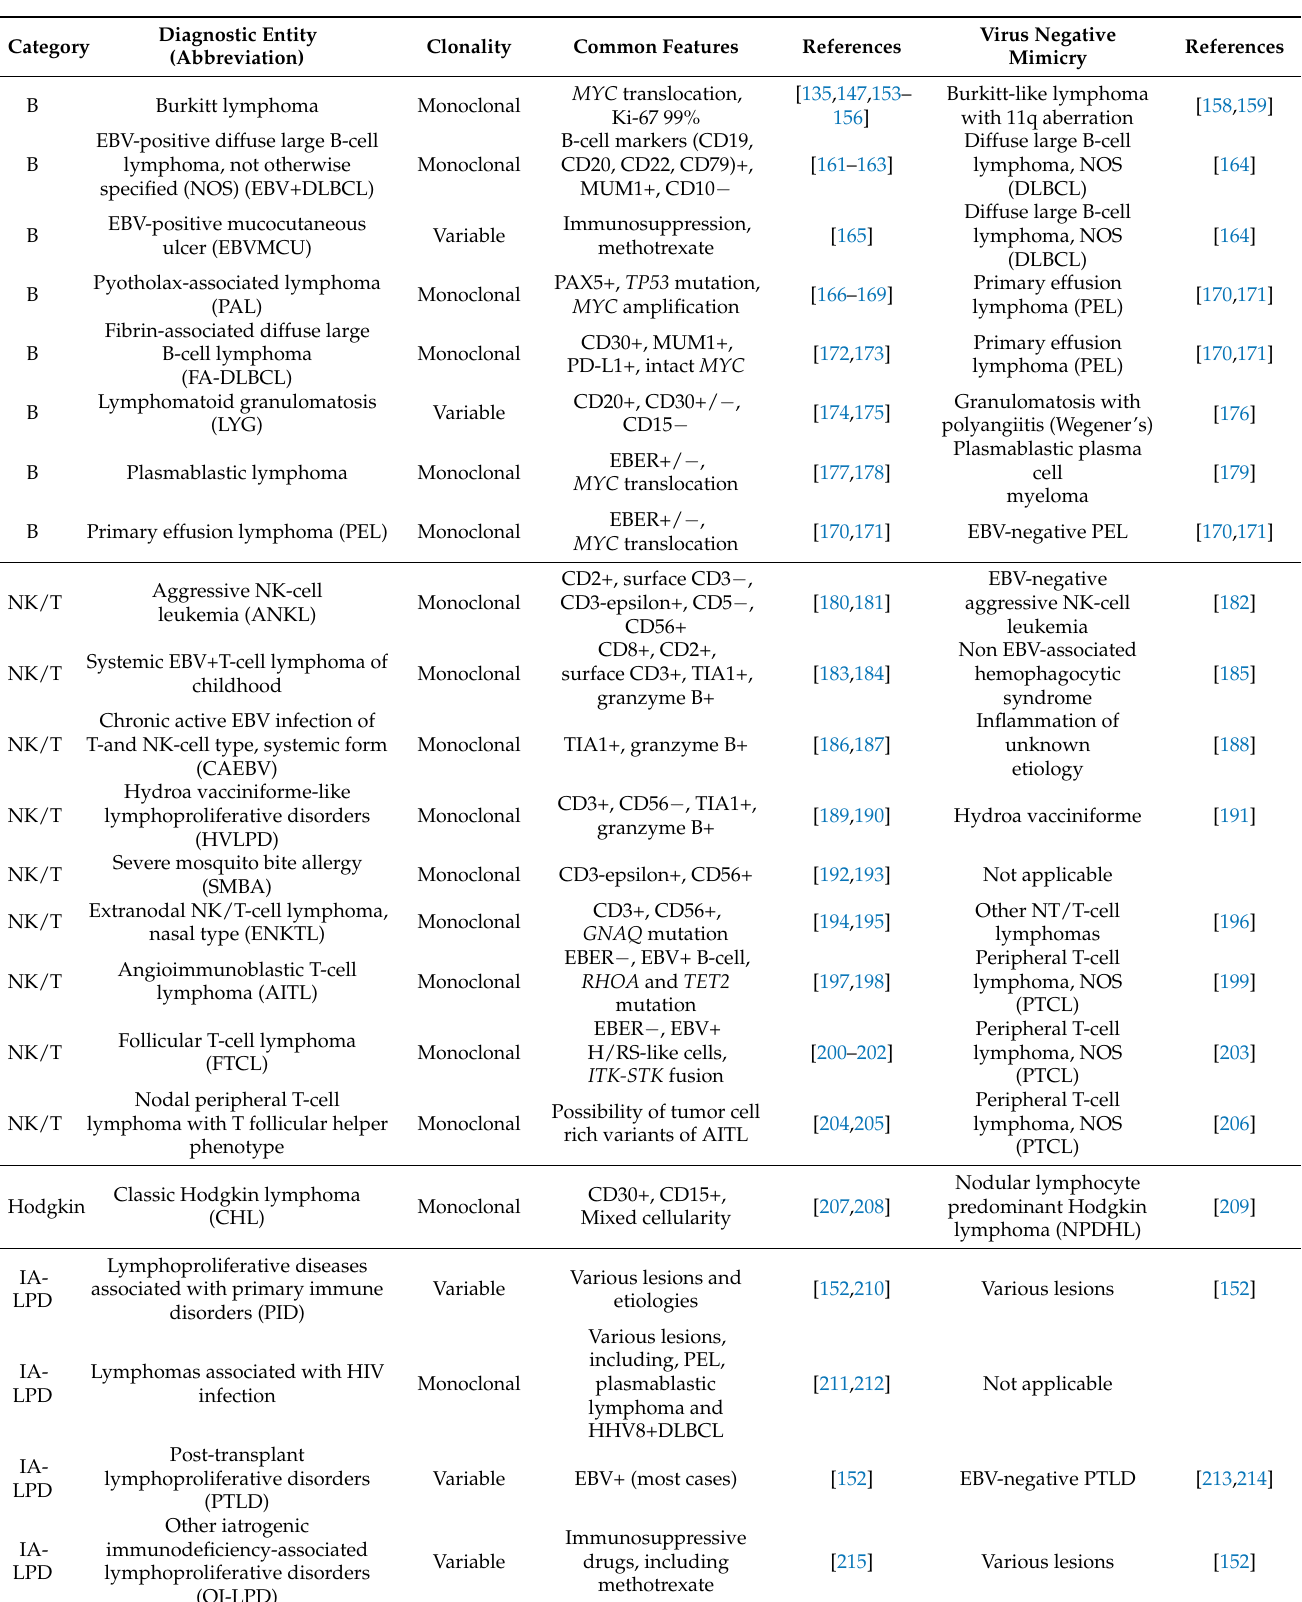
Table 4. Association between hematolymphoid lesions and